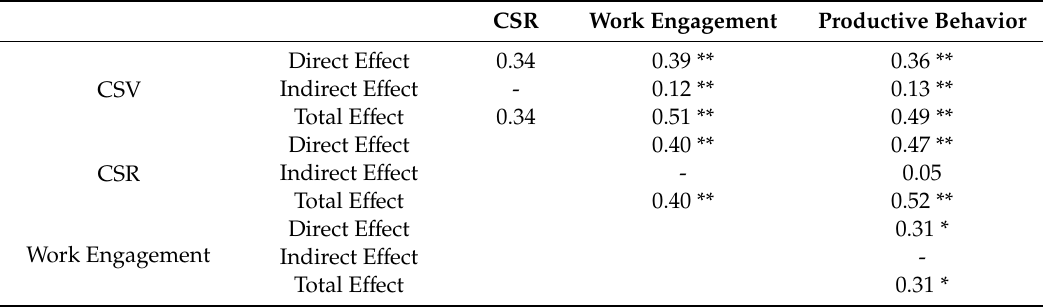
Table 8. Coe ffi cients of direct, indirect, and total e ff ects. CSR Work Engagement Productive